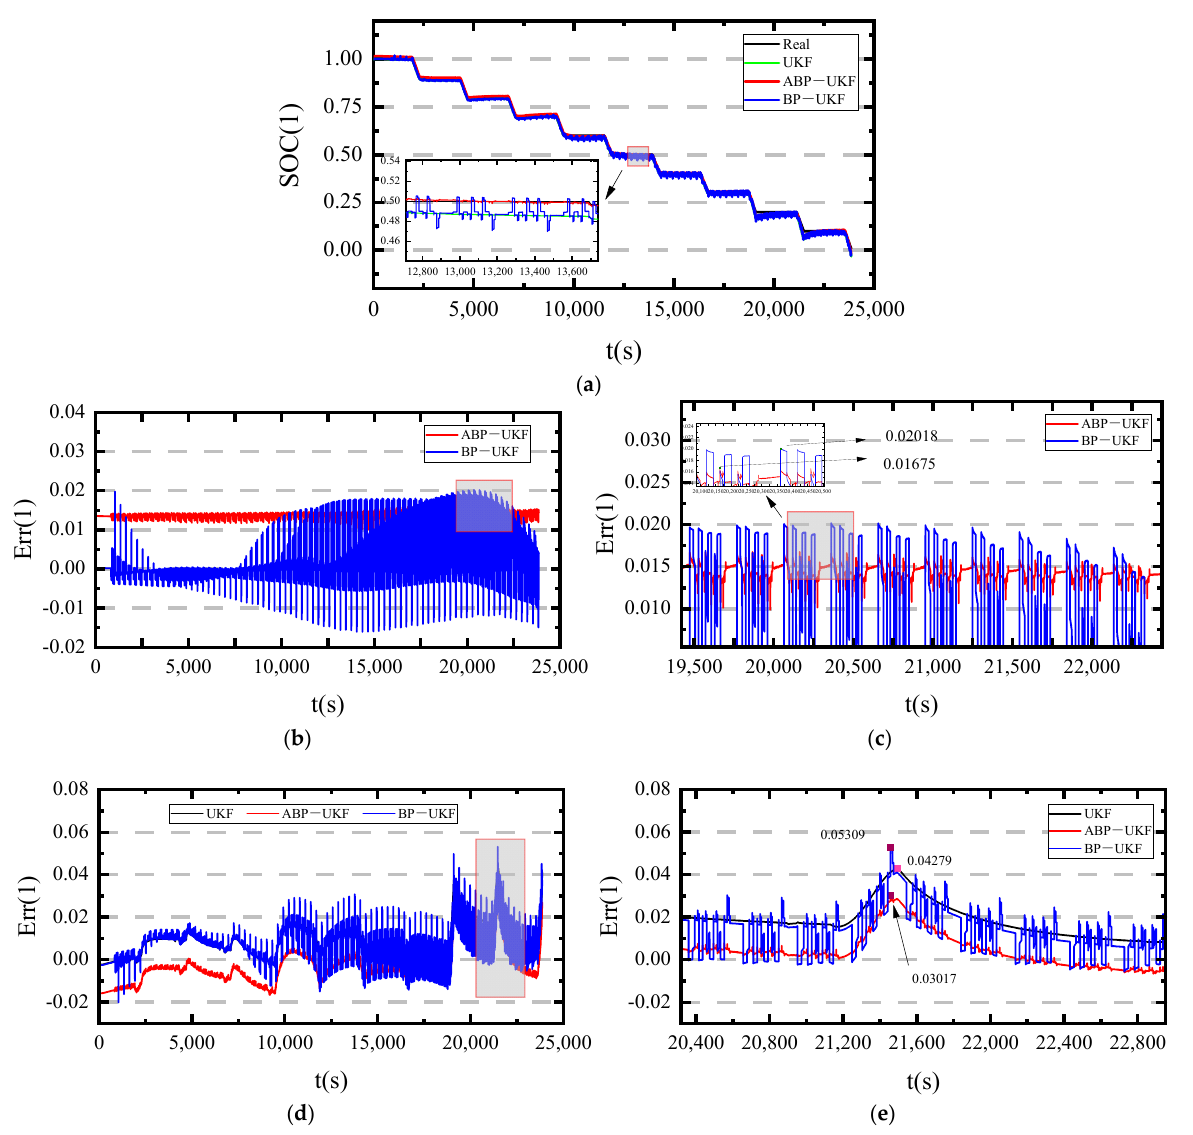
Figure 8. SOC estimation and error comparison under HPPC. ( a ) Estimation results of the SOC under the HPPC working conditions. ( b ) Correction value based on the UKF algorithm. ( c ) Enlarged view of the correction value based on the UKF algorithm. ( d ) Error of the SOC under the HPPC working conditions. ( e ) Enlarged view of the error of the SOC under the HPPC working conditions. Figure 8a is the SOC estimation results of various algorithms under the HPPC exper- imental conditions; Figure 8b is the correction value of the BP-UKF and the ABP-UKF based on the UKF estimation results; Figure 8c is the partially enlarged view of Figure 8b; Figure 8d is based on the SOC value estimated by the reference value, the error curve of the UKF, the BP-UKF, the ABP-UKF algorithms, respectively; Figure 8e is the partially enlarged diagram of Figure 8c. It can be seen from Figure 8a that the overall SOC estima- tion effect of the UKF algorithm and the BP-UKF algorithm fluctuates greatly, and the proposed ABP-UKF algorithm can track the SOC well in the entire estimation process with slight fluctuations; the estimation result of the ABP-UKF algorithm can be closer to the reference value. The UKF algorithm and the BP-UKF algorithm have local oscillations, which can partly explain why the proposed algorithm can effectively correct the error estimated by the UKF algorithm, and the proposed algorithm has better performance on the tracking performance. From the corrected error curve in Figure 8b, the convergence of the ABP-UKF algorithm is better than that of the BP-UKF algorithm, and the enlarged curve can also reveal this result more clearly. The error curve of Figure 8d shows that the maximum error estimated by the UKF algorithm is 4.31%. Because of the oscillation of the estimated results of the BP-UKF algorithm, the maximum error reaches 5.31%. The BP algorithm can correct the estimated value of UKF to a certain extent, but it will generally oscillate within a certain range. The maximum estimated error of the ABP-UKF algorithm is 3.02%, which can greatly attenuate the compensatory oscillation of the BP-UKF algo- rithm. The modification of the ABP algorithm to the UKF algorithm was verified, and the estimation results were modified and optimized. The criteria for the SOC estimation re- sults under the HPPC working conditions are shown in Table 2.